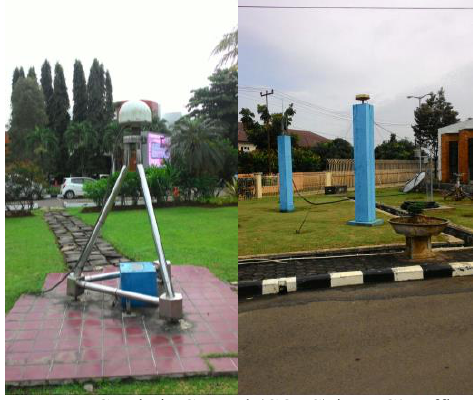
Figure 4. Geodetic Control (CORS) in BIG’s office